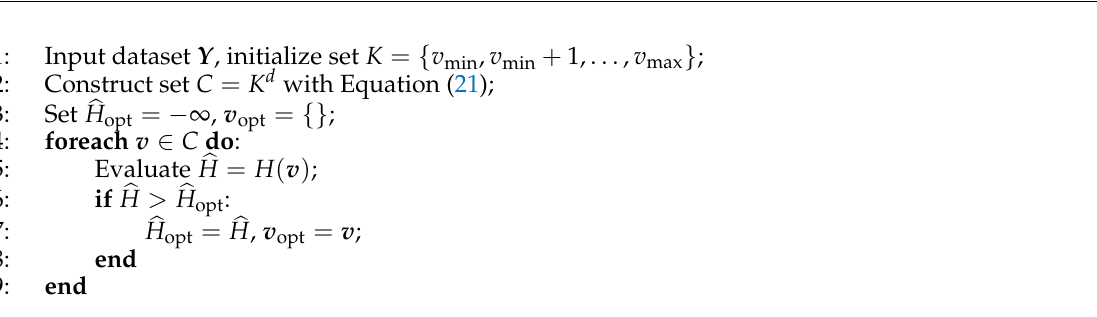
Algorithm 5: Exhaustive search for optimum histogram binning v